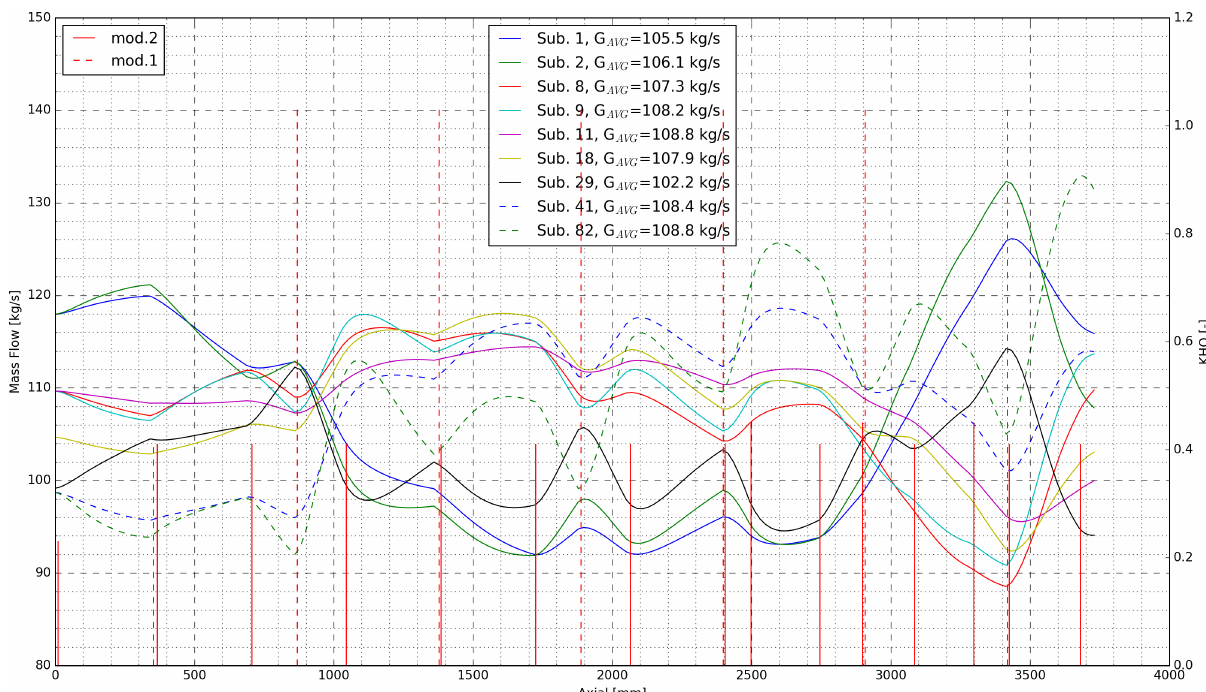
Figure 7. Mass Flow in u2c16 - 97 TVSA-T